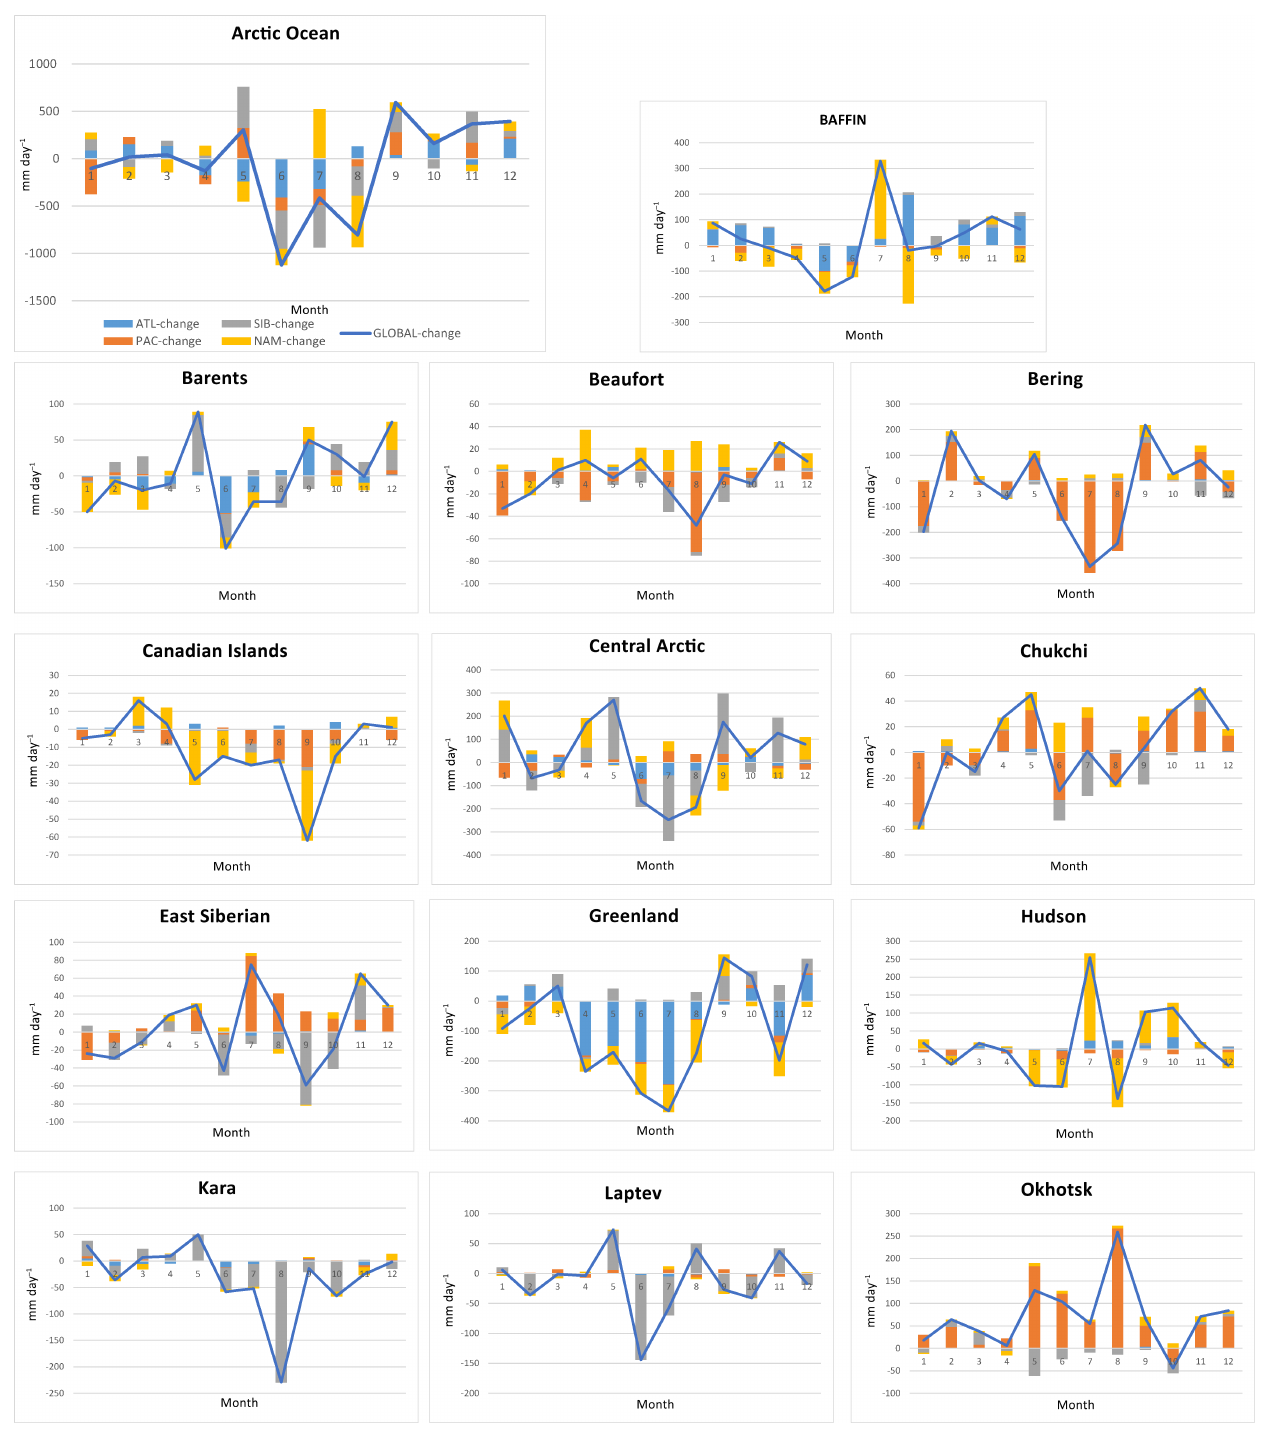
Figure 9. Differences between mean values of moisture transport for precipitation (MTP) until 2003 and mean values after 2003 for every source region for the Arctic Ocean (AO) and its 13 subregions. Statistical significance of the differences is displayed in Table